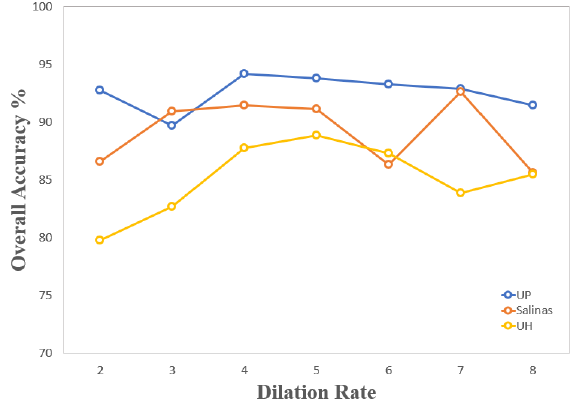
Figure 9. OA curve of two datasets with different dilation rates.